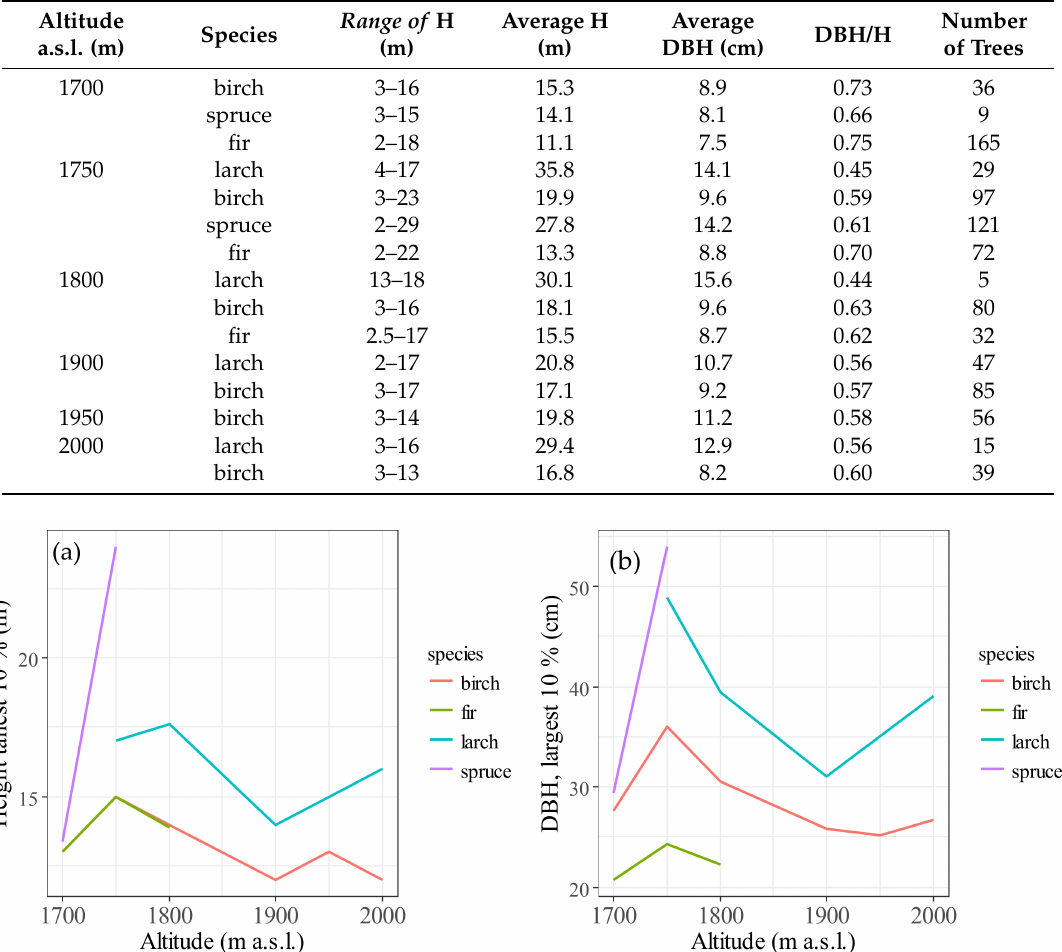
Figure 4. Height and DBH of the largest 10% of Betula ermanii , Abies nephrolepis , Larix gmelinii , and Picea jezoensis trees growing along an altitude gradient on Changbai Mountain: ( a ) height of the tallest 10% of trees for each species at each altitude; and ( b ) DBH of the 10% largest DBH-trees for each species at each